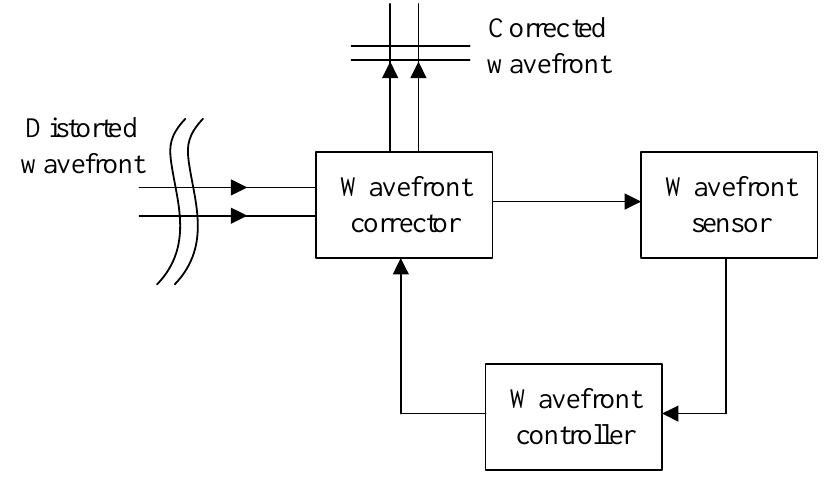
Figure 16. Composition of an AO system.